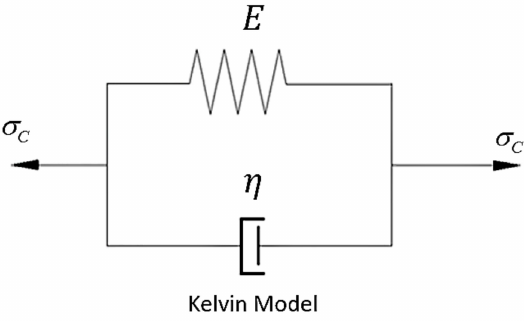
Figure 1. Kelvin rheological model (with a constant external load σ c